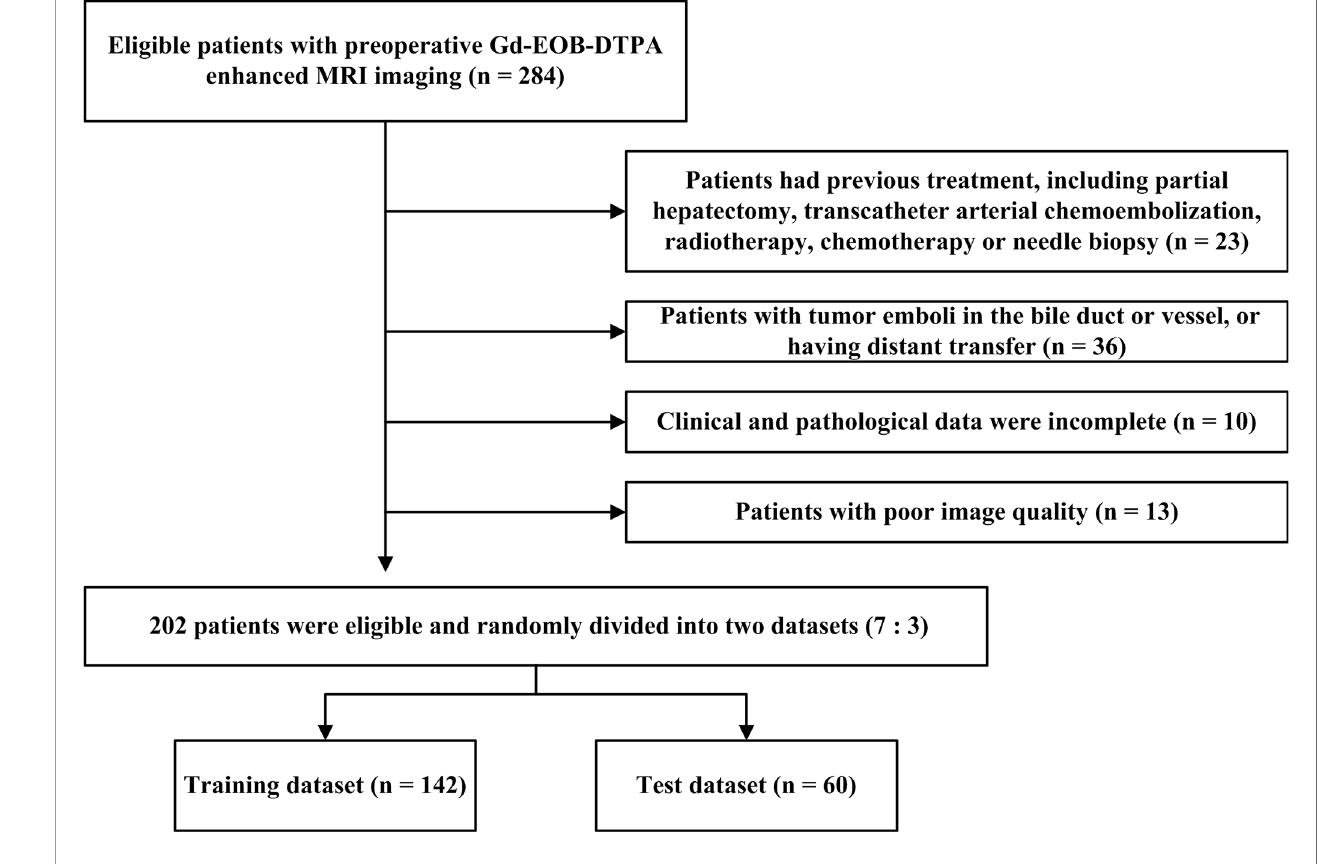
FIGURE 1 | Patient selection fl ow